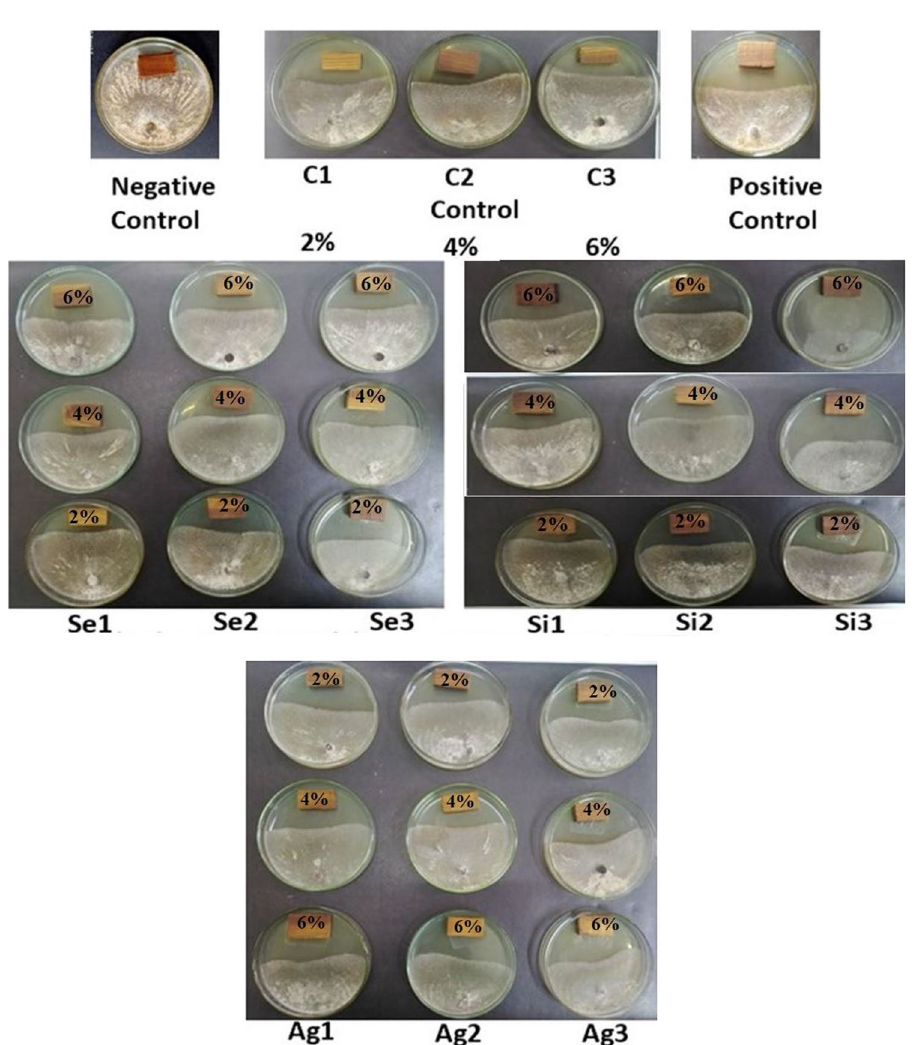
Figure 1. The visual observation of antifungal activity of wood-treated with acetone extracts from pomegranate peels collected from trees sprayed with different doses of Se1: 0.025 mg/L; Se2: 0.05 mg/L; Se3: 0.1 mg/L; Ag1: 5 mL/L; Ag2: 7.5 mL/L; Ag3: 10 mL/L; Si1: 0.5 mg/L; Si2: 1 mg/L; Si3: 2 mg/L, and untreated trees (C1, C2,